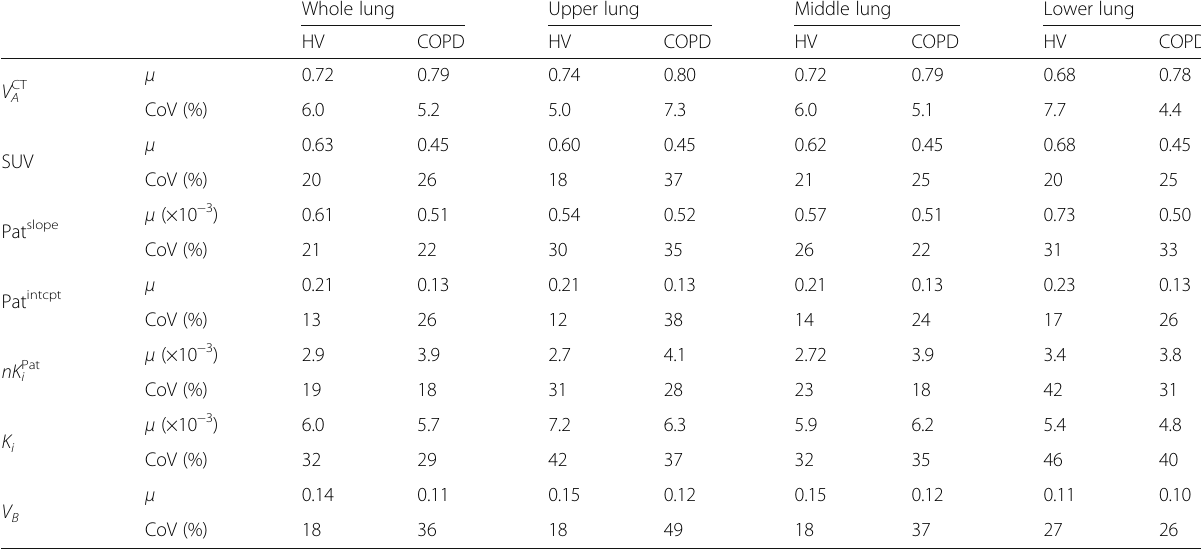
Table 2 Parameter values across HV ( N = 10) and COPD ( N = 10) subjects in four lung ROIs Whole lung Upper lung Middle